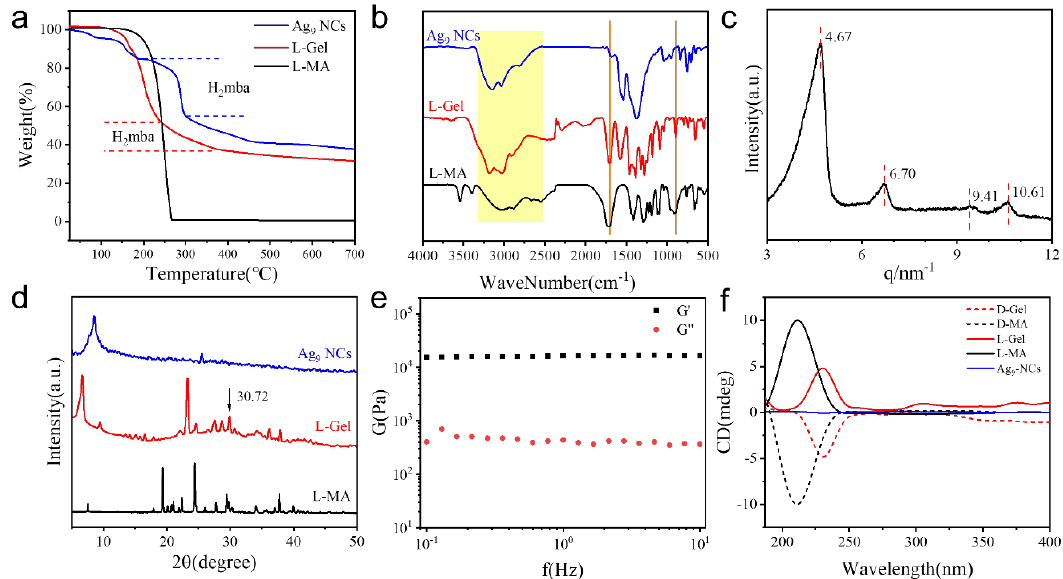
Figure 3. ( a ) TGA and ( b ) FT–IR spectra of lyophilized Ag 9 -NCs solution, L–MA and Ag 9 -NCs/L–MA xerogel. ( c ) SAXS results of Ag 9 -NCs/L–MA xerogel. ( d ) XRD results of lyophilized Ag 9 –NCs solution, L–MA and Ag 9 -NCs/L–MA xerogel. ( e ) Variation of elastic modulus (G′) and viscous modulus (G″) as a function of frequency (τ = 10 Pa). ( f ) CD spectra of Ag 9 –NCs solution, L–MA, Ag 9 -NCs/L–MA hydrogels, D–MA and Ag 9 -NCs/D–MA hydrogels.